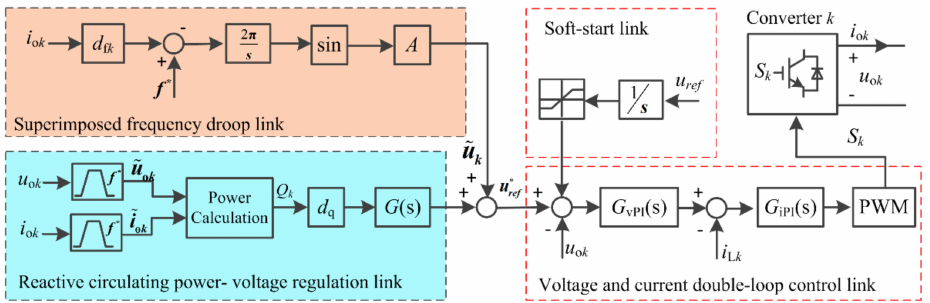
Figure 2. Proposed current sharing control structure based on injected small ac